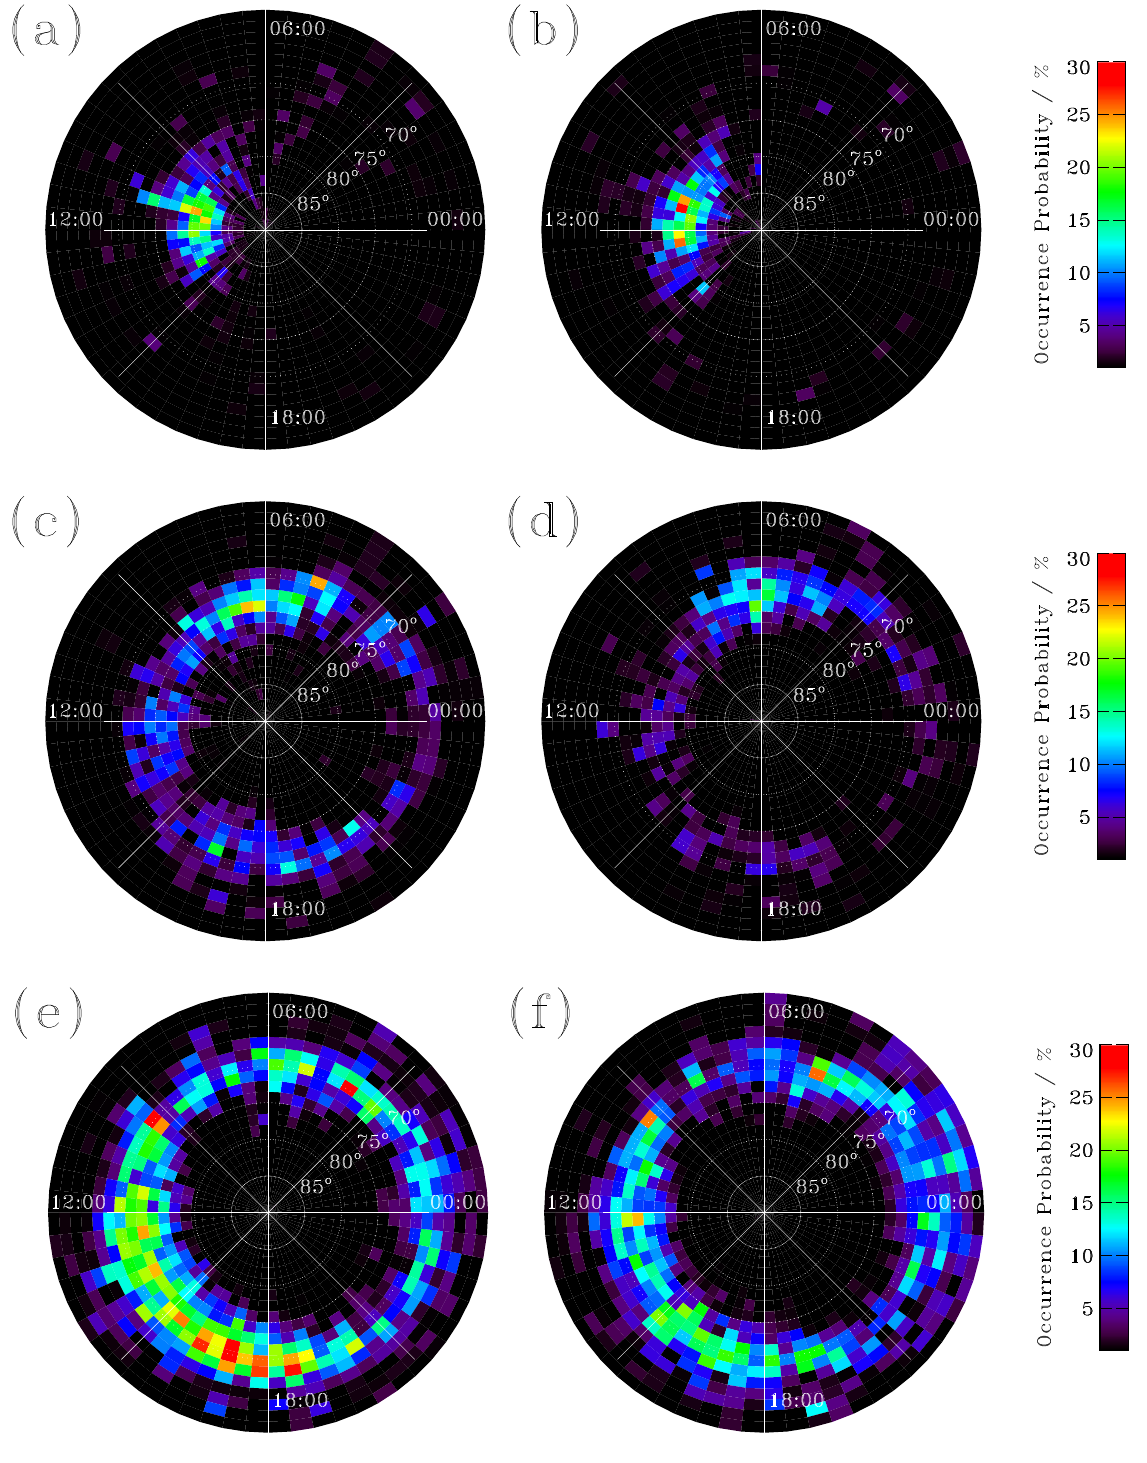
Fig. 6. He 2 + ion occurrence probabilities sampled during (a) IMF B Z > 0 and (b) IMF B Z < 0 conditions, for energies between 1.8 and 6.9 keV. Probabilities sampled during (c) IMF B Z > 0 and (d) IMF B Z < 0 conditions for energies between 7.7 and 21.4 keV. Probabilities sampled during (e) IMF B Z > 0 and (f) IMF B Z < 0 conditions for energies between 24.3 and 50.3 keV. The data are shown in the same format as Fig.